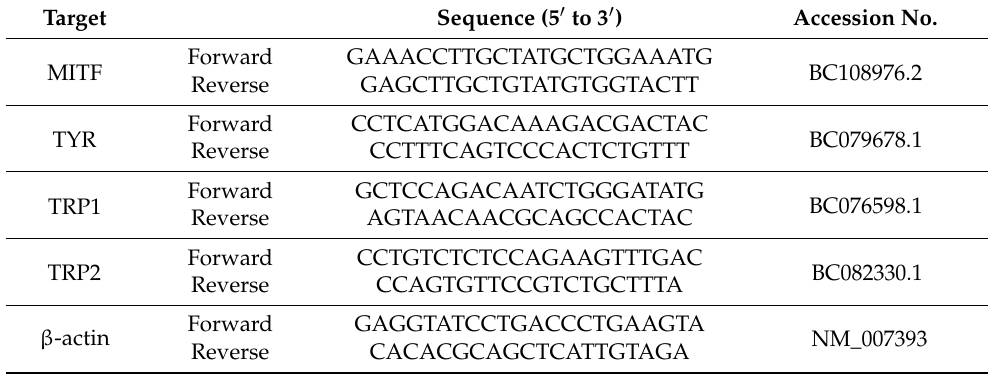
Table 1. Sequences of primers used in